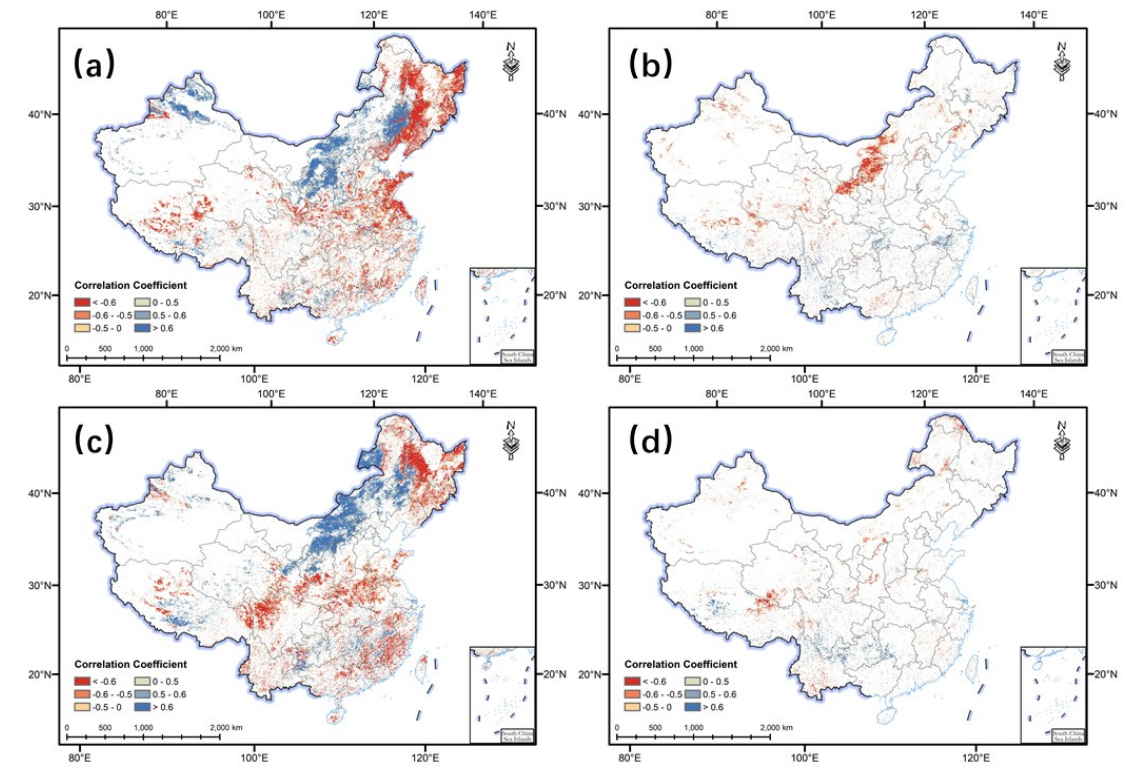
Figure 3. Spatial pattern of the partial correlation coefficients of the terrestrial net ecosystem productivity (NEP) with air temperature and precipitation in China from 1981 to 2018. ( a ) NEP with precipitation from 1981 to 1999; ( b ) NEP with air temperature from 1981 to 1999; ( c ) NEP with precipitation from 2000 to 2018; ( d ) NEP with air temperature from 2000 to